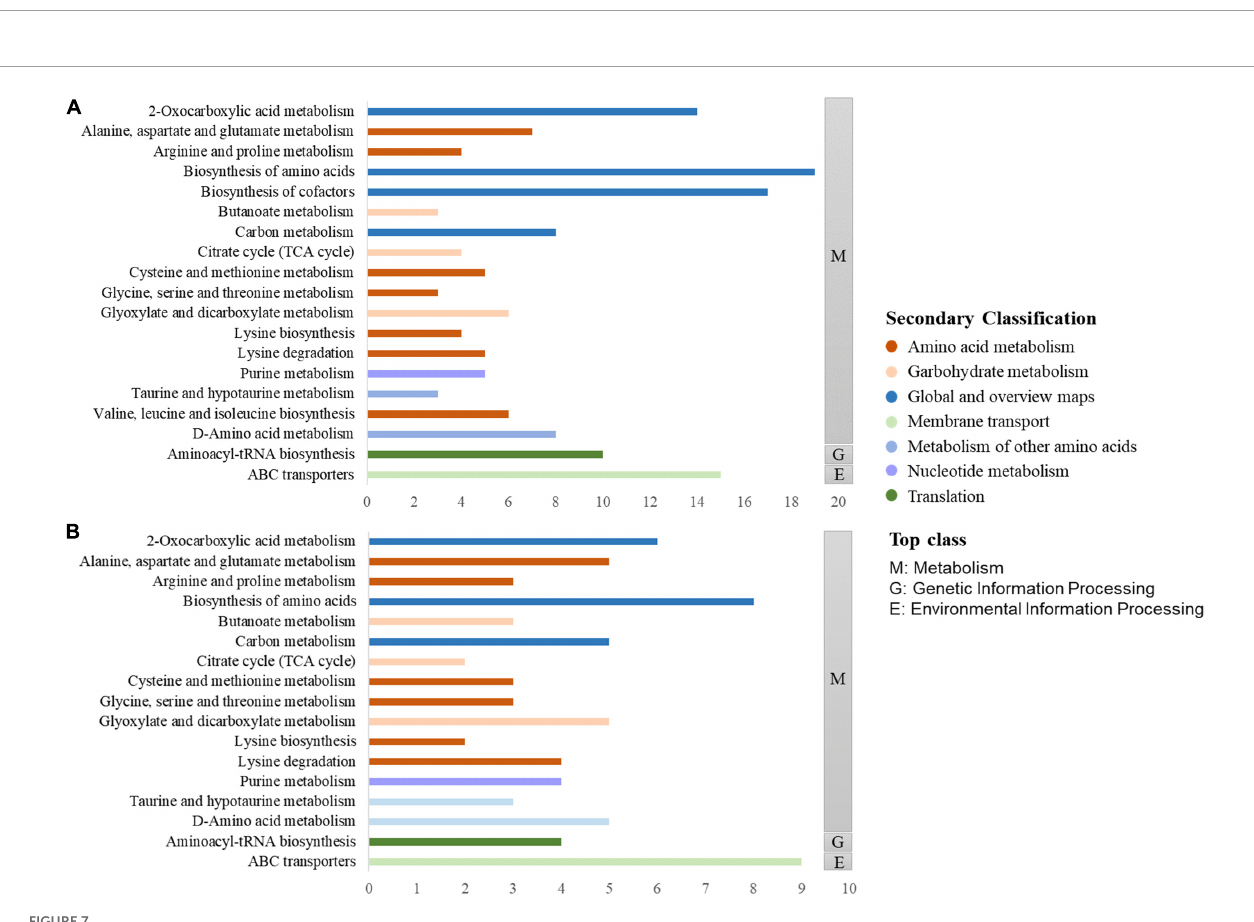
Frontiers in Nutrition